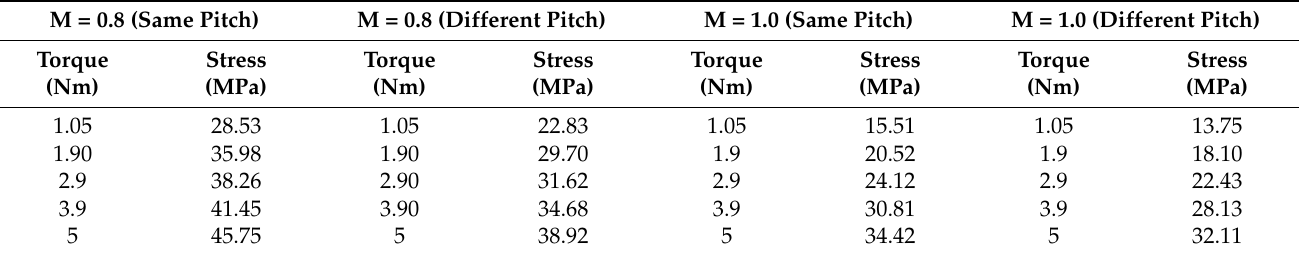
Table 3. FEA results for different model long tooth worm & helical gear.